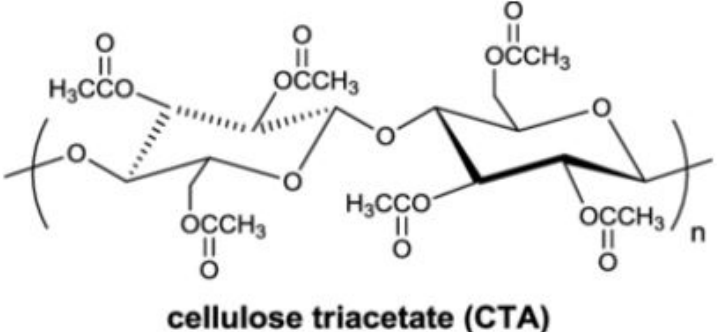
Figure 1. Molecular structure of CTA polymer unit.